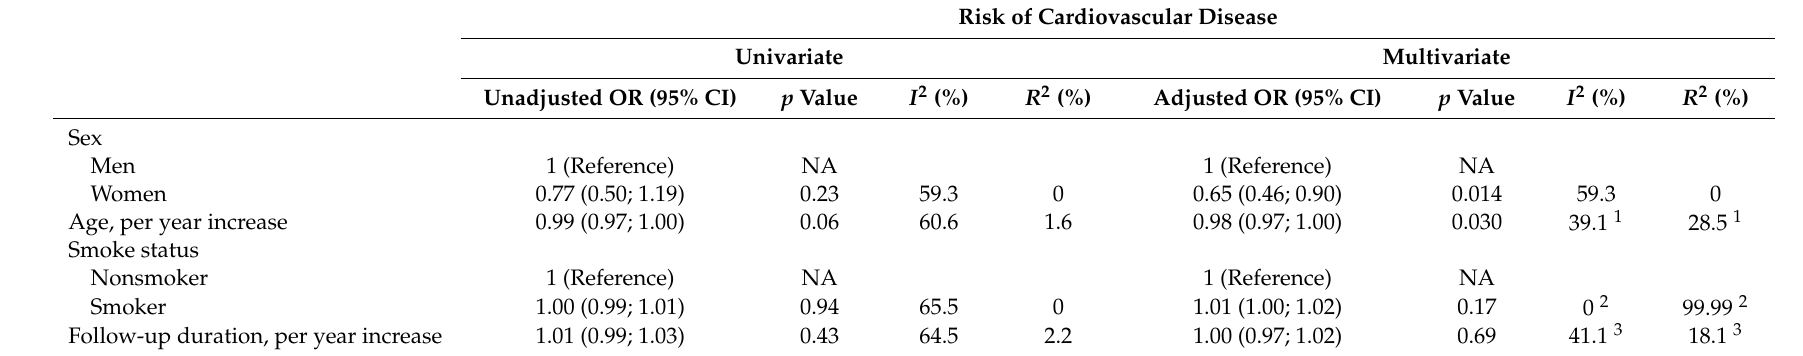
Table 2. Meta-regression Analysis of Association between Covariates and Risk of Cardiovascular